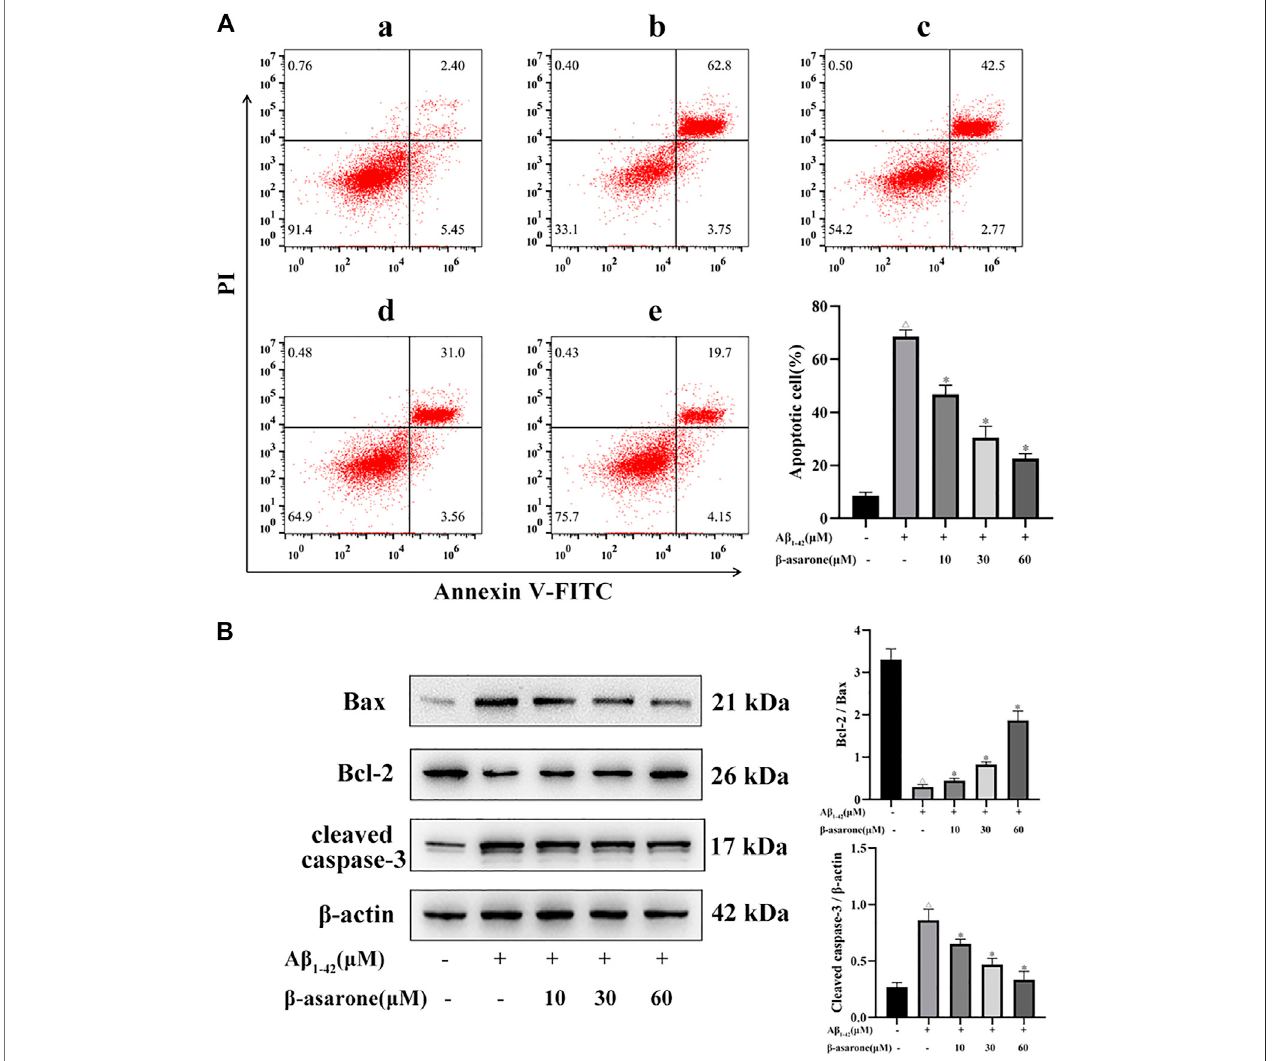
FIGURE 2 | Effect of β -asarone on apoptosis in PC12 cells. (A) Apoptosis was measured by fl ow cytometry, and the percentage of early and late apoptotic cells wasquanti fi ed.Theleftlowerquadrantrepresentsthenormalcells,therightlowerquadrantrepresentstheearlyapoptosiscells,therightupperquadrantrepresentsthe late apoptosis cells, and the left upper quadrant represents the death cells. a, Control group; b, A β 1 – 42 -alone treatment group; c, A β 1 – 42 + β -asarone (10 μ M) group; d, A β 1 – 42 + β -asarone (30 μ M) group; e, A β 1 – 42 + β -asarone (60 μ M) group. (B) Expression levels and quanti fi cation of Bcl-2/Bax and cleaved caspase-3 were examinedbyWesternblot. △ p < 0.05comparedwiththecontrolgroup;* p < 0.05comparedwiththeA β 1 – 42 -alonetreatmentgroup.Thedatawereexpressedasmean ± SD of three independent experiments, each in